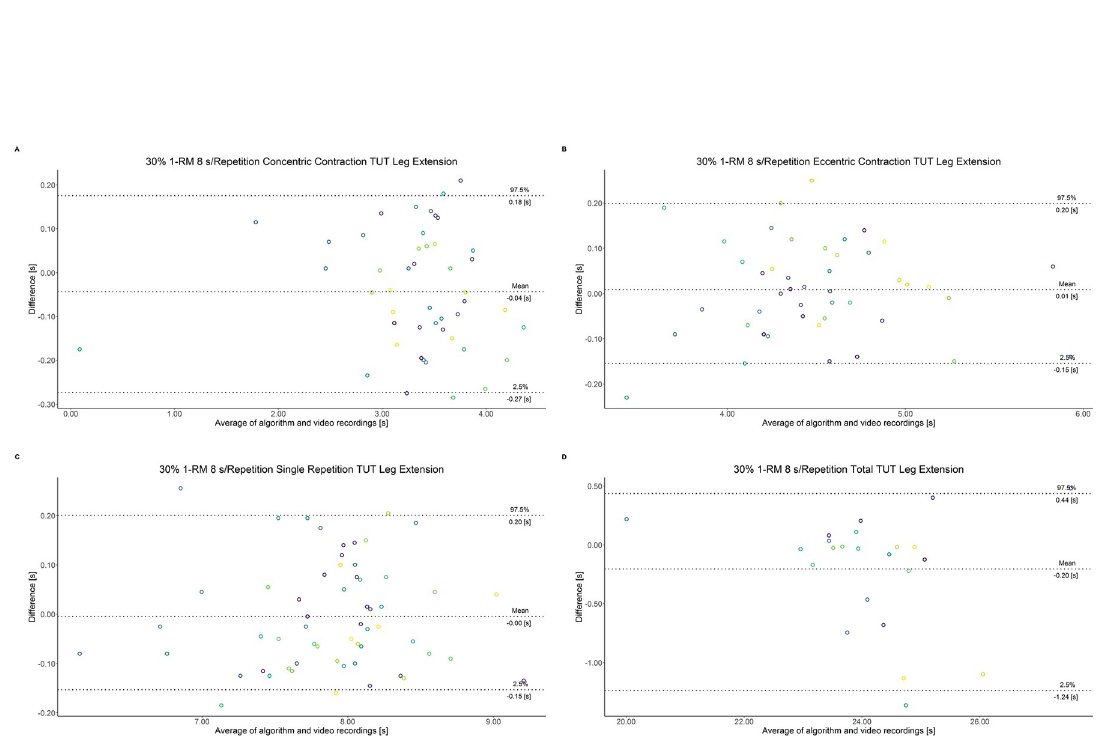
Fig 6. Bland-Altman plots of agreement between algorithmically accelerometer derived and video recordings derived contraction- specific phases of the leg extension machine at 30% 1-RM with a velocity of 8 s per repetition. A: Concentric contraction phase. B: Eccentric contraction phase. C: Single repetition. D: Total